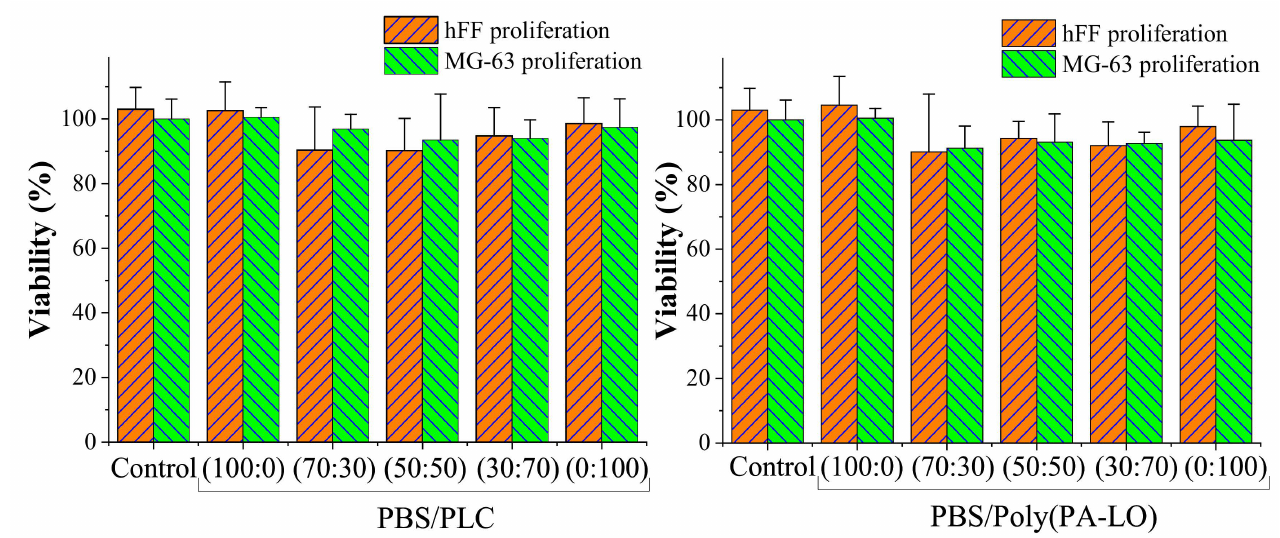
Figure 13. Cell adhesion and proliferation onto the surface of the PBS/PLC and PBS/poly(PA-LO) blend films. MTT assay was performed at 24 h (adhesion test) and 96 h (proliferation test) of